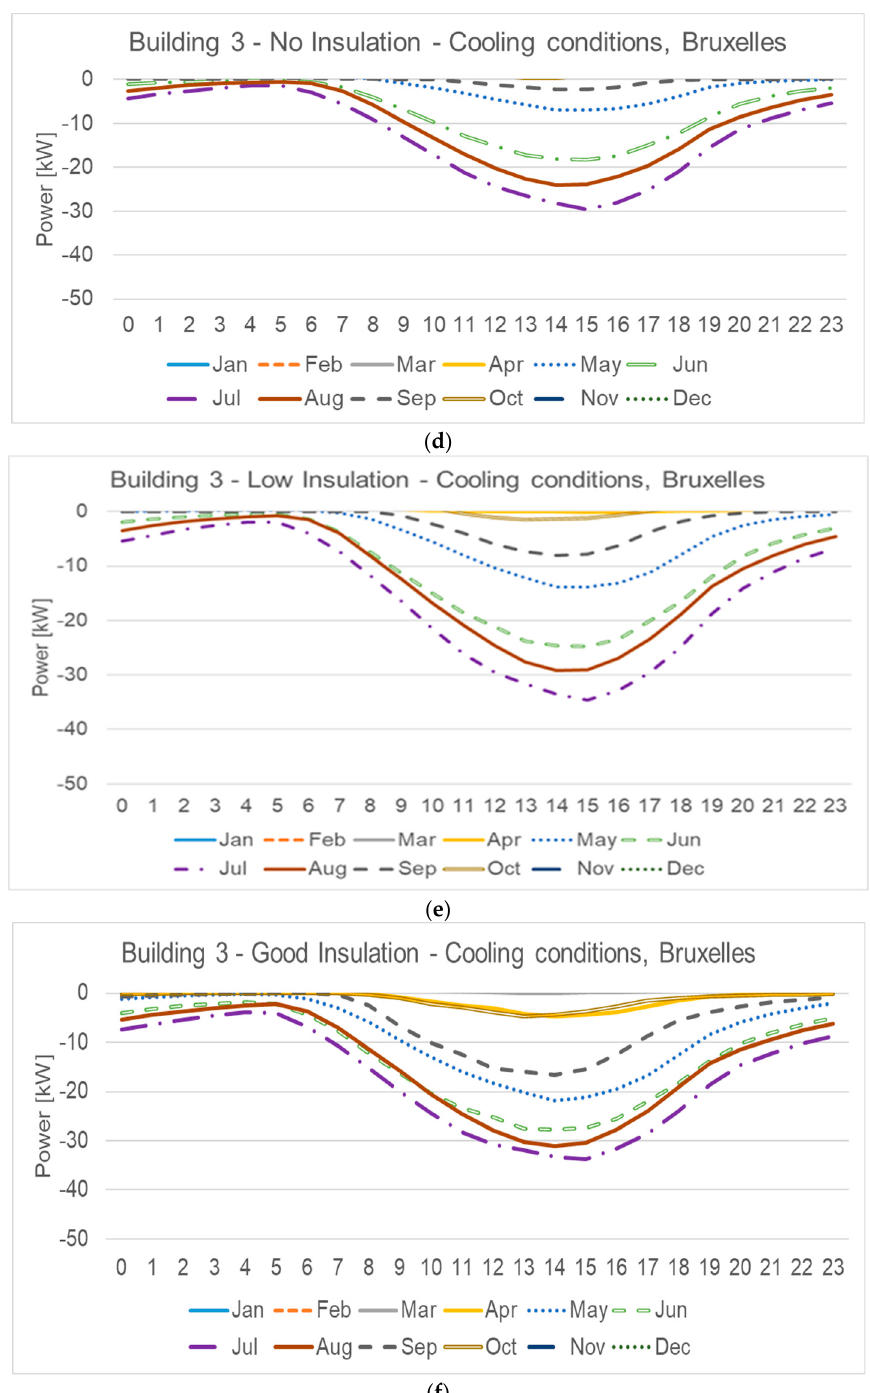
Figure 4. Hourly sensible load of the average monthly day for Building 3, Bruxelles (Cfb) climate conditions: ( a ) Heating conditions and no insulation, ( b ) heating conditions and low insulation, ( c ) heating conditions and good insulation, ( d ) cooling condition and no insulation, ( e ) cooling condition and low insulation, ( f ) cooling condition and good insulation. Table 5. Average monthly climatic data and energy demand of Helsinki.